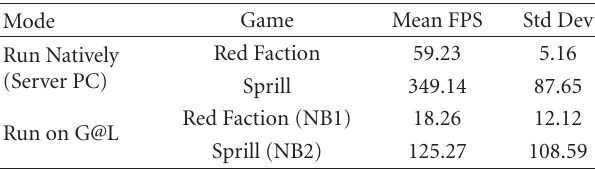
Table 1: Frame rate per second for tested games run natively and on G@L system.